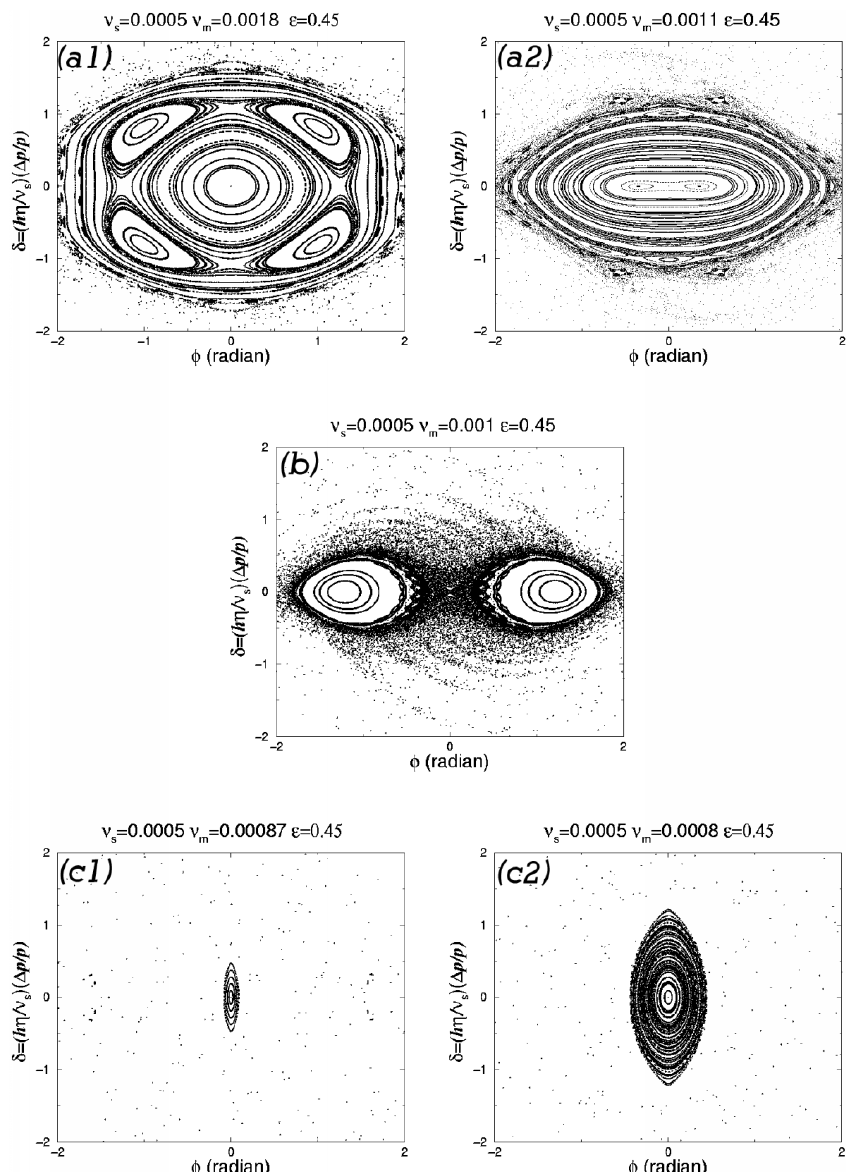
D p , as opposed to the rotating n s p